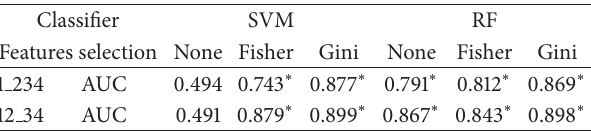
Table 3: Performance assessment (AUC) for screening.